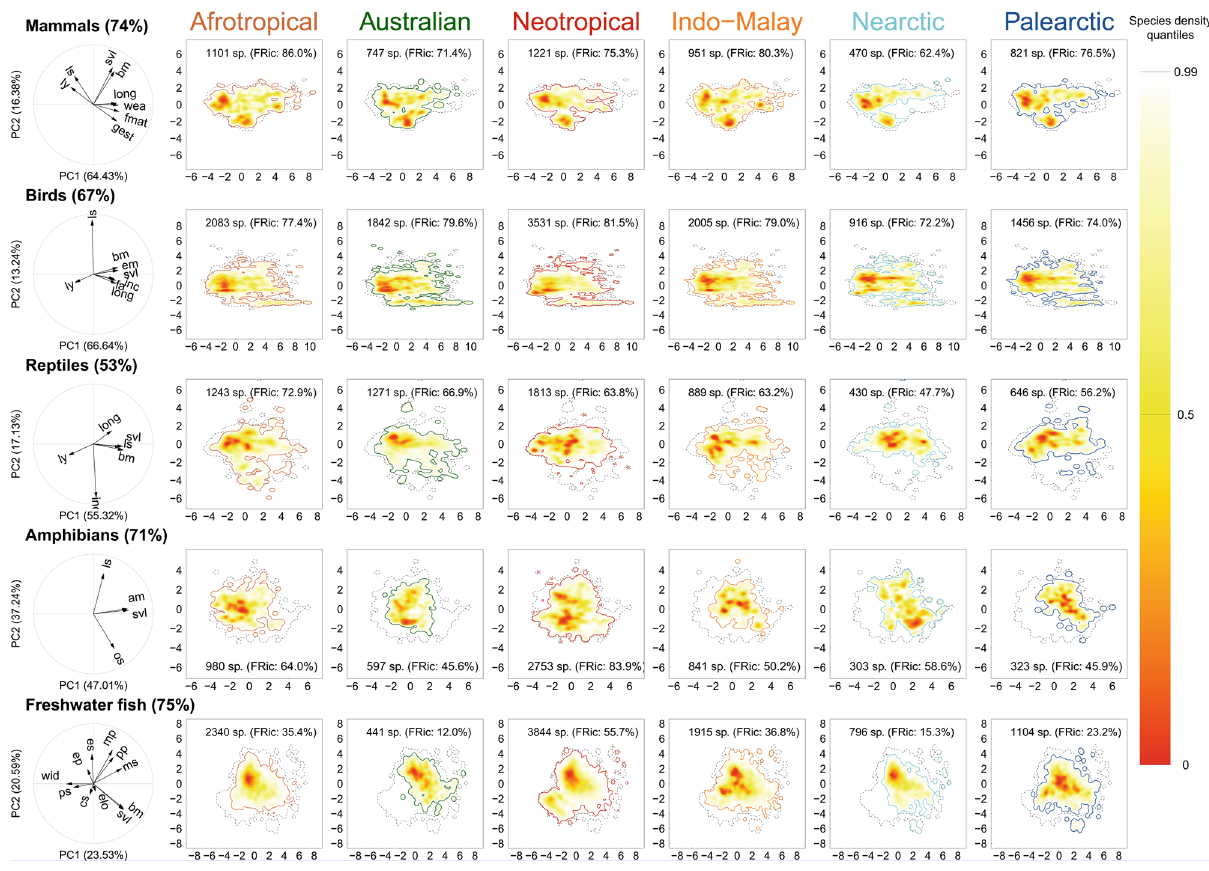
Fig. 1 Functional spectra of vertebrates in the six biogeographic realms. Probabilistic species distributions are de fi ned by the fi rst two principal components of PCA considering the main functional traits for each group (see details in ‘ Methods ’ ). The correlation circles show the loadings of the considered traits in the resulting PCA for each group. De fi nitions of the trait abbreviations are in Table 1. For each group, the percentage of described species considered in the analysis is indicated. The colour gradient (red-yellow-white) depicts different densities of species in the functional space (i.e. red areas are more densely populated). Thick contour lines indicate the 0.99 quantiles, and thinner ones indicate quantile 0.5. The grey dotted line indicates the world ’ s 0.99 quantiles. The legends within each panel show the number of species and the functional richness measured as a proportion of the world ’ s functional richness. Global functional spectra of the six taxonomic groups (i.e. considering all species) are presented in Supplementary Fig. 3. Functional spectra and correlation circles have been made using R (codes are available online, see ‘ Code availability ’ ). Source data are provided as a Source data fi